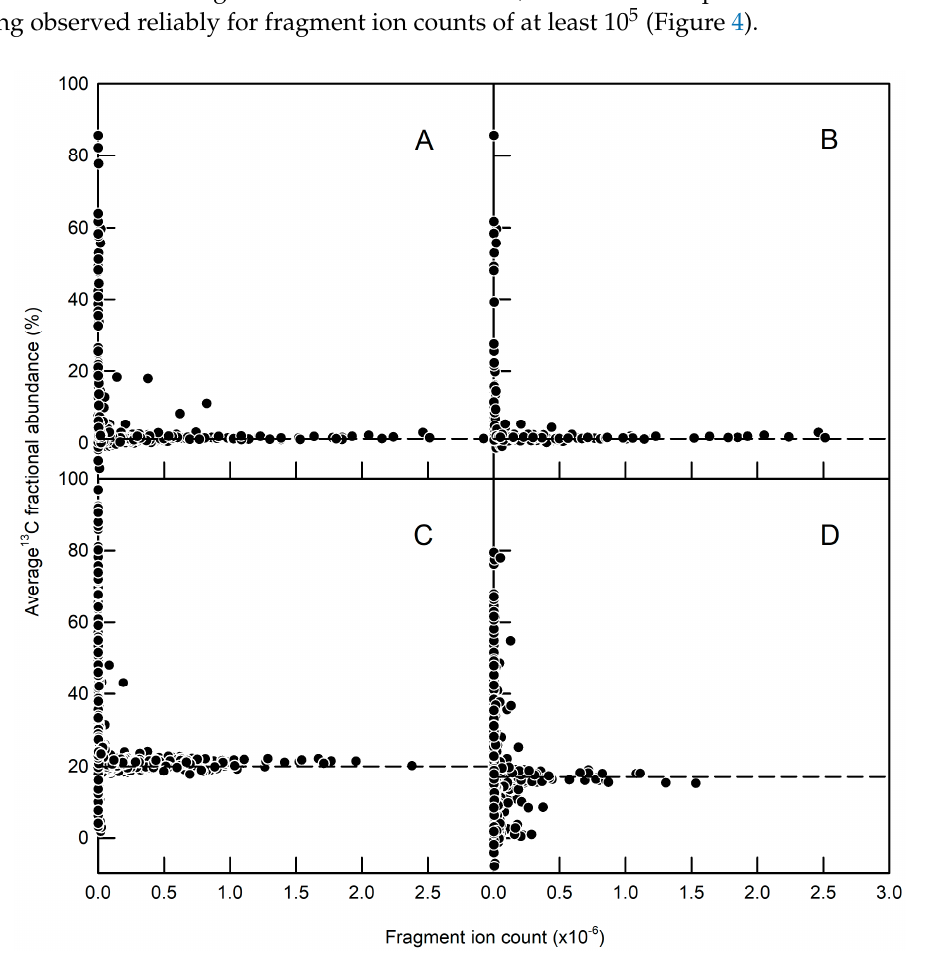
Figure 4. Effect of fragment ion abundance on the measured fractional enrichments of amino acid fragments derived from A. thaliana root protein hydrolysates. Seedlings were cultured on either ( A , B ) unlabelled glucose, or ( C , D ) 20% [ 13 C 6 ]glucose. ( A , C ) Fragments from the total protein fraction obtained from wild-type seedlings and seedlings constitutively expressing GFP. ( B , D ) Fragments from immunopurified GFP obtained from seedlings with constitutive GFP expression. Negative values for 13 C fractional abundances are the result of using a base-line correction algorithm and they highlight the unreliability of signals with low ion counts. In the same way, there are many signals with low fragment ion counts that have infeasibly high 13 C fractional abundances.